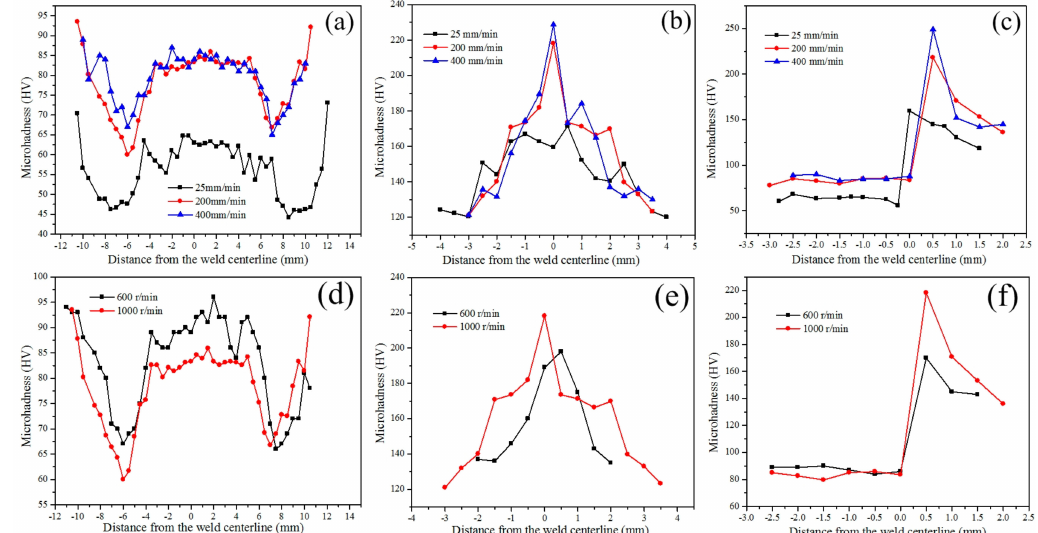
Figure 16. The microhardness distribution of Al/steel lap joints with different rotation speeds and welding speeds. ( a – e ) are transverse microhardness distribution; ( c , f ) are microhardness distribution through the thickness. ( a ) Al side joint with different welding speeds; ( b ) Q235A steel at 0.5 mm below the weld interface with different welding speeds; ( c ) microhardness distribution in thickness direction with different welding speeds; ( d ) Al side joint with different rotation speeds; ( e ) Q235A steel at 0.5 mm below the weld interface with different rotation speeds; and ( f ) microhardness distribution in thickness direction with different rotation speeds.